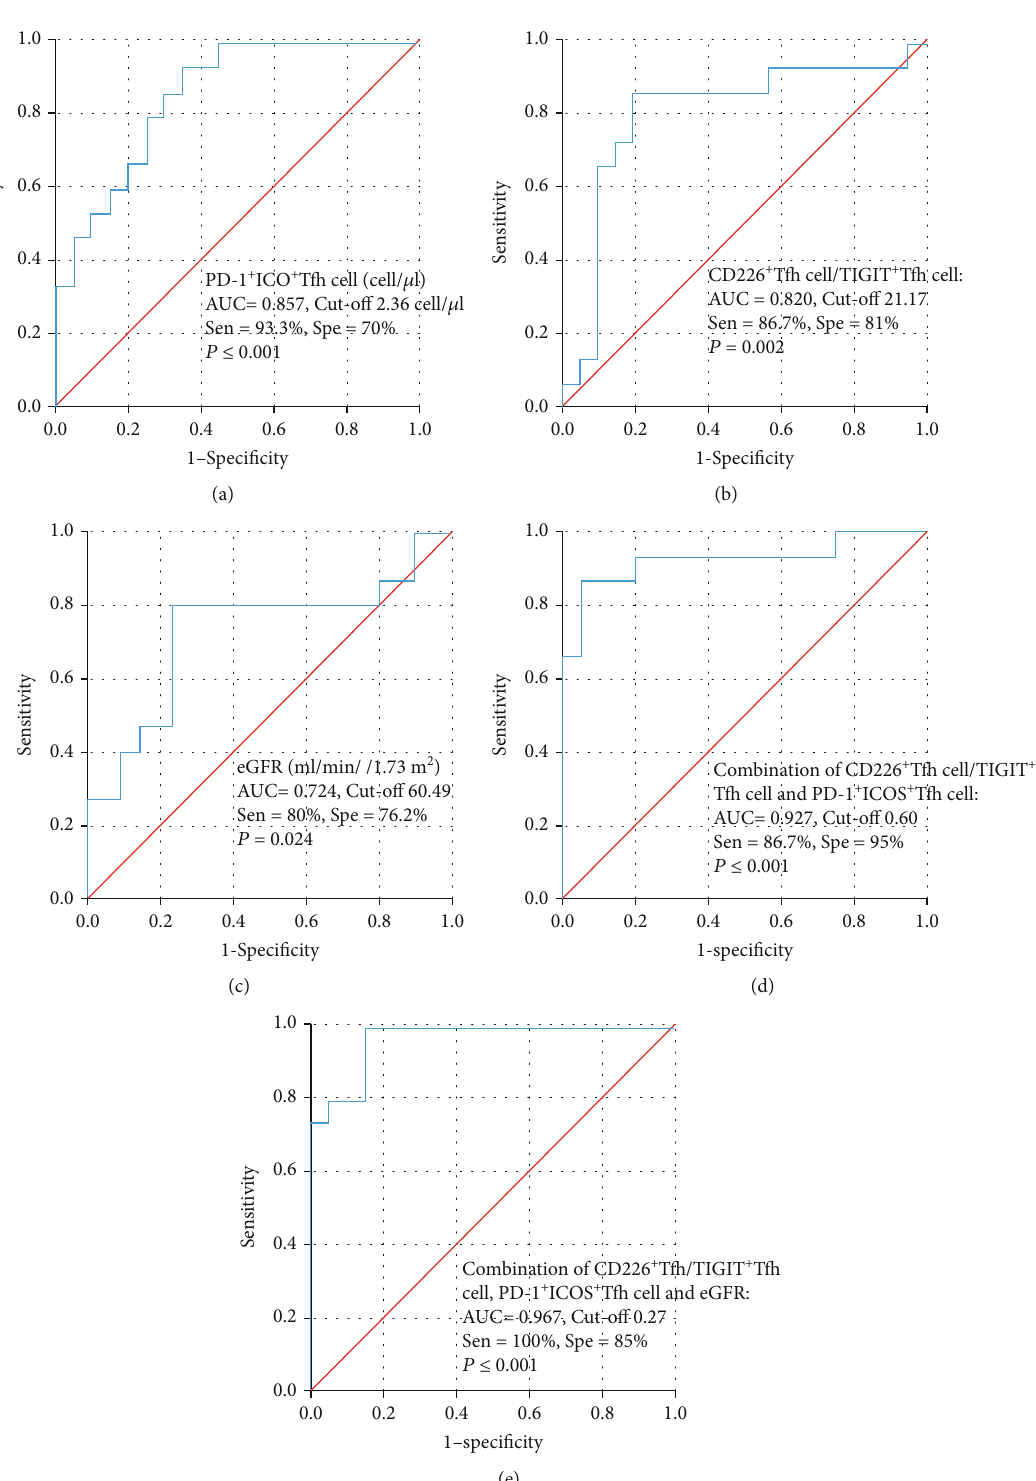
Figure 5: ROC curves for diagnosis of CAMR. (a) ROC curve of PD-1 + ICOS + Tfh cells. (b) ROC curve of CD226 + Tfh cell/TIGIT + Tfh cell ratio. (c) ROC curve of eGFR. (d) Combination of CD226 + Tfh cell/TIGIT + Tfh cell ratio and PD-1 + ICOS + Tfh cells. (e) ROC curve of combination of CD226 + Tfh cell/TIGIT + Tfh cell ratio, PD-1 + ICOS + Tfh cells, and